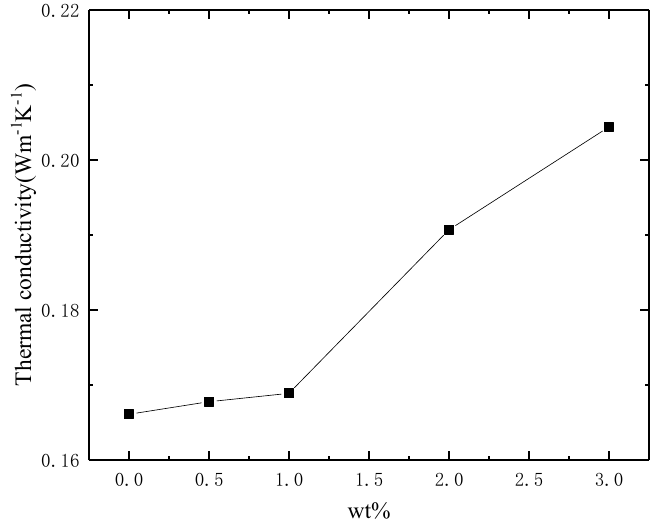
Figure 4. Thermal conductivity of prepared nanofluid samples with different mass fraction.